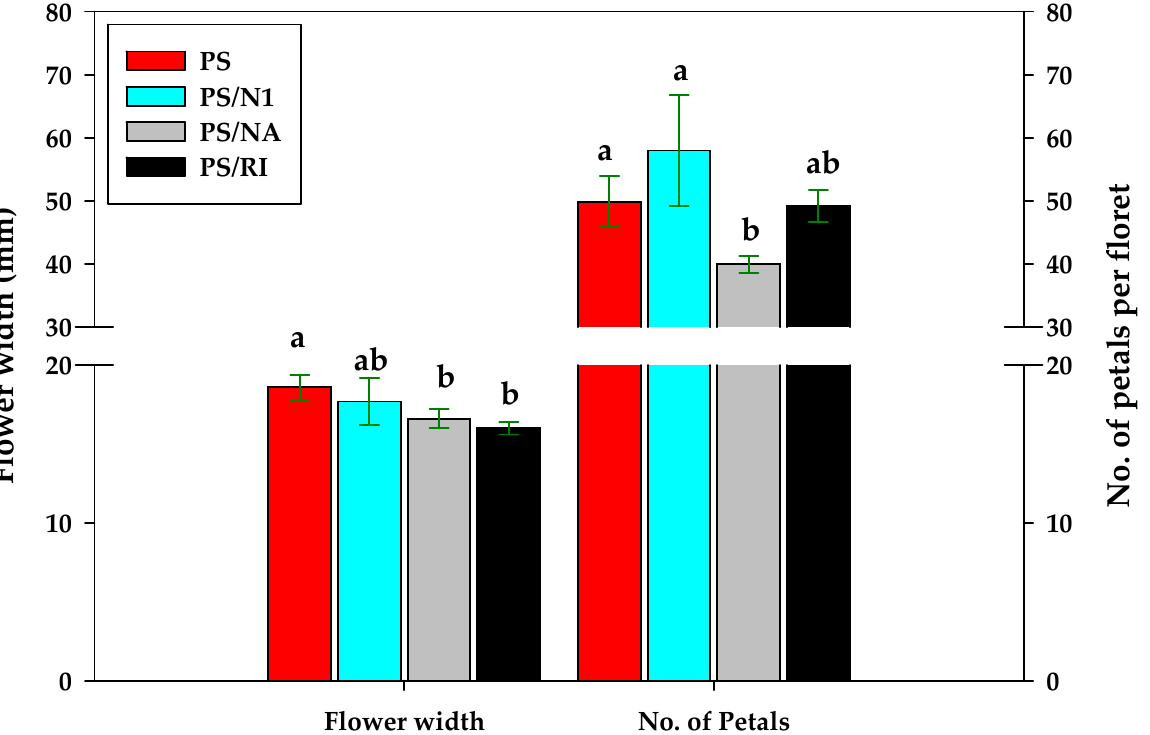
No. of Petals Figure 7. Flower characteristics of one scion and three grafted cut rose flowers grown in the green- house during the summer season. PS: scion plant of spray rose Rosa hybrida cv. Pink Shine; PS/N1: PS grafted onto Rosa multiflora cv. Hort No. 1; PS/NA: PS grafted onto Rosa canina cv. Natal Briar; PS/RI: PS grafted onto Rosa indica cv. Major. Vertical bars are standard deviations ( n = 15). Small letters at the data points indicate mean separation between the values by Duncan’s multiple range test at p =